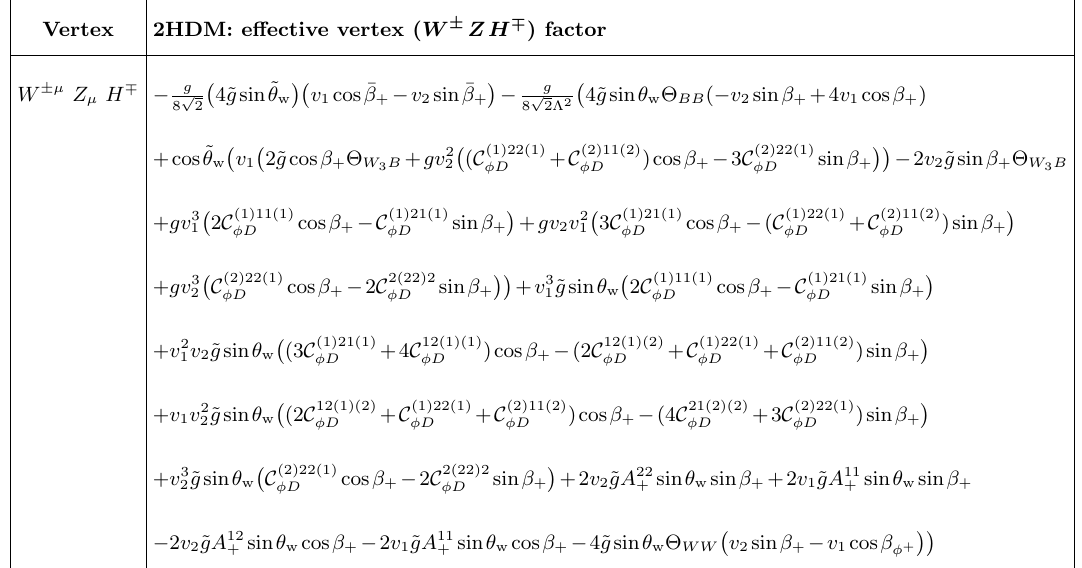
Table 38. 2HDM: coupling of charged scalar ( H (cid:7) ) with a charged gauge boson ( W (cid:6) ) and a neutral gauge boson ( Z